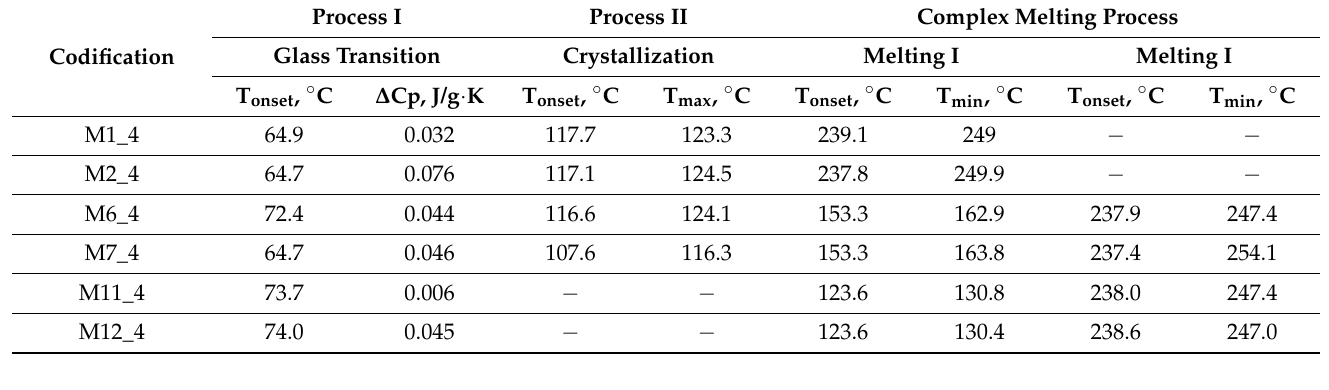
Table 3. Thermal behavior and characteristics.